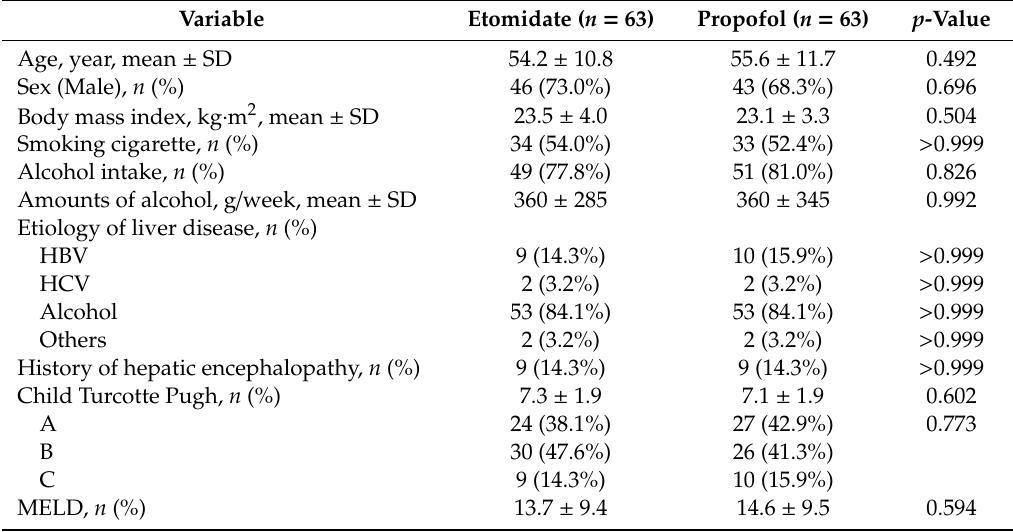
Table 1. Baseline patient characteristics.